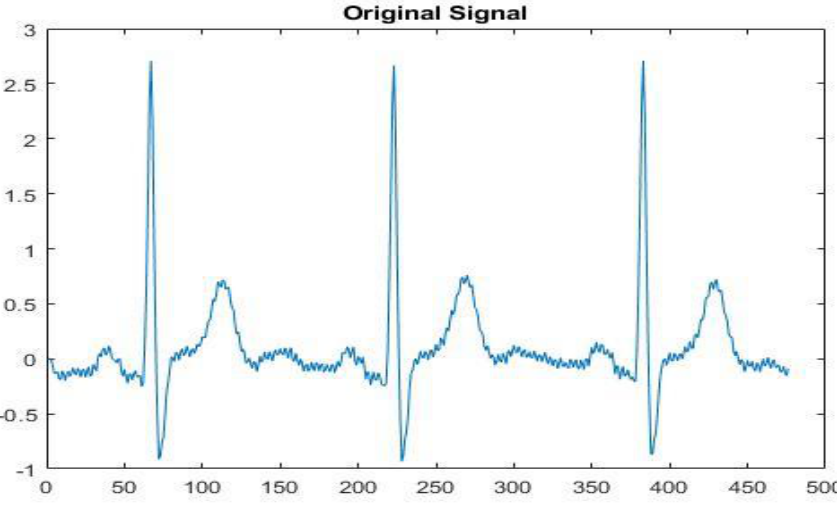
Figure 3. Original Electro-Encephalo-Graphy (EEG) signal.